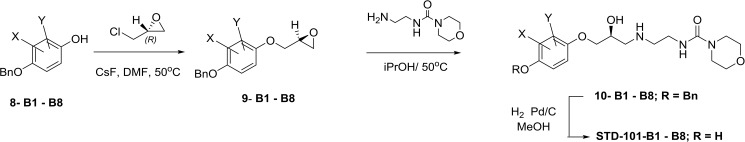
General method for the synthesis of compounds STD-101-B1 to B8.